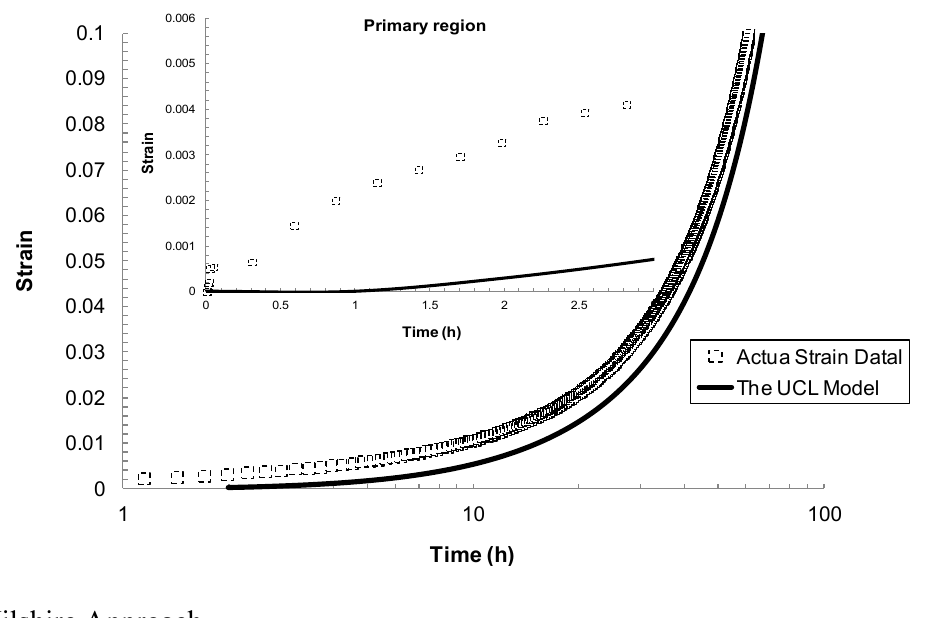
Figure 15. Creep curve for 923 K, 260 MPa predicted using the Uniaxial Creep Lifing approach.